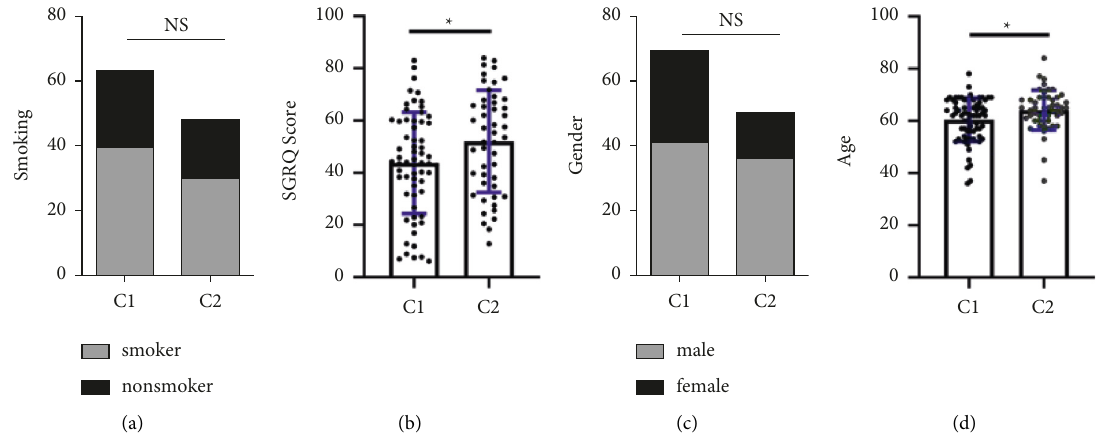
Figure 3: Comparison of clinical characteristics in different subgroups. (a, c) The status of gender and smoking in different subgroups is shown. (b, d) The status of age and SGRQ score in subgroups showed significant